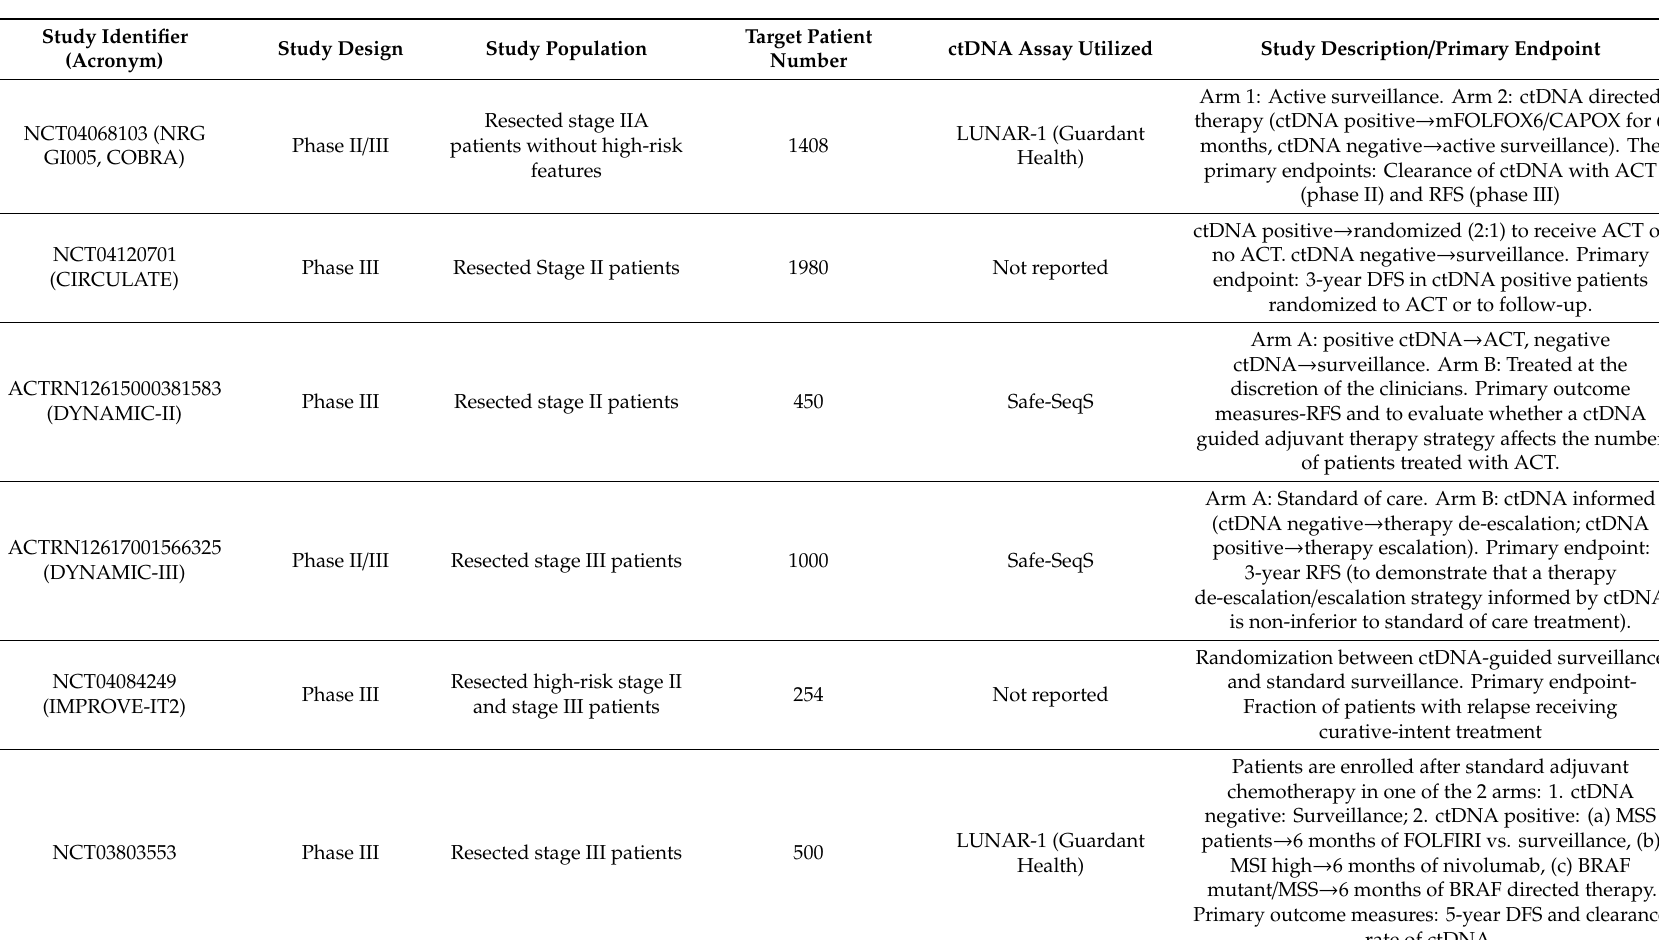
Table 2. Ongoing and upcoming clinical trials investigating the clinical utility of ctDNA in the management of patients with early-stage colon cancer